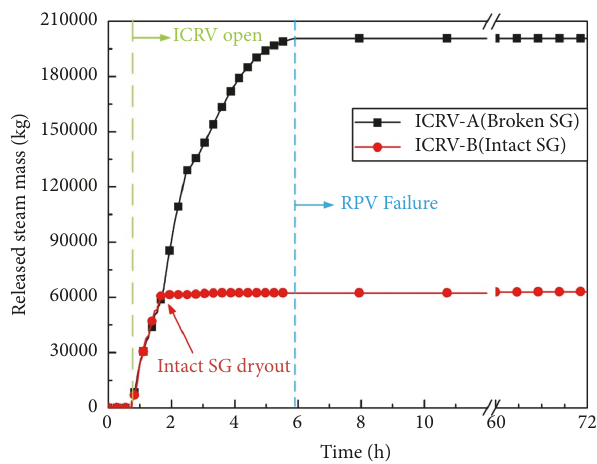
Figure 11: Released steam mass through ICRV in the ICRV-CNMT